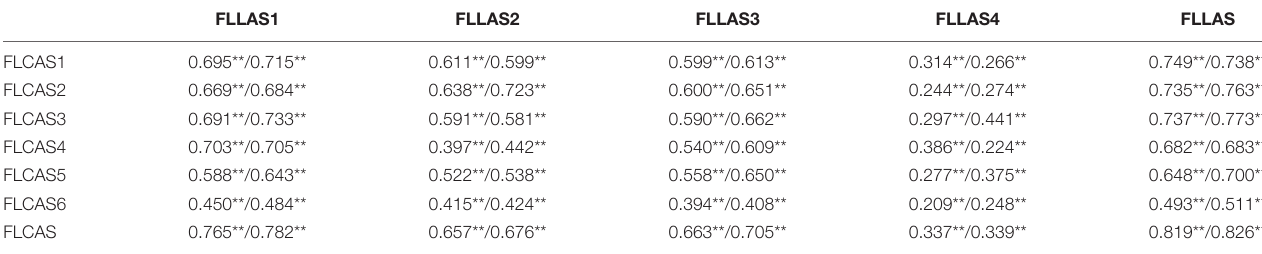
TABLE 3 | Correlations between FLCAS and FLLAS scales in both phases ( N = 182).